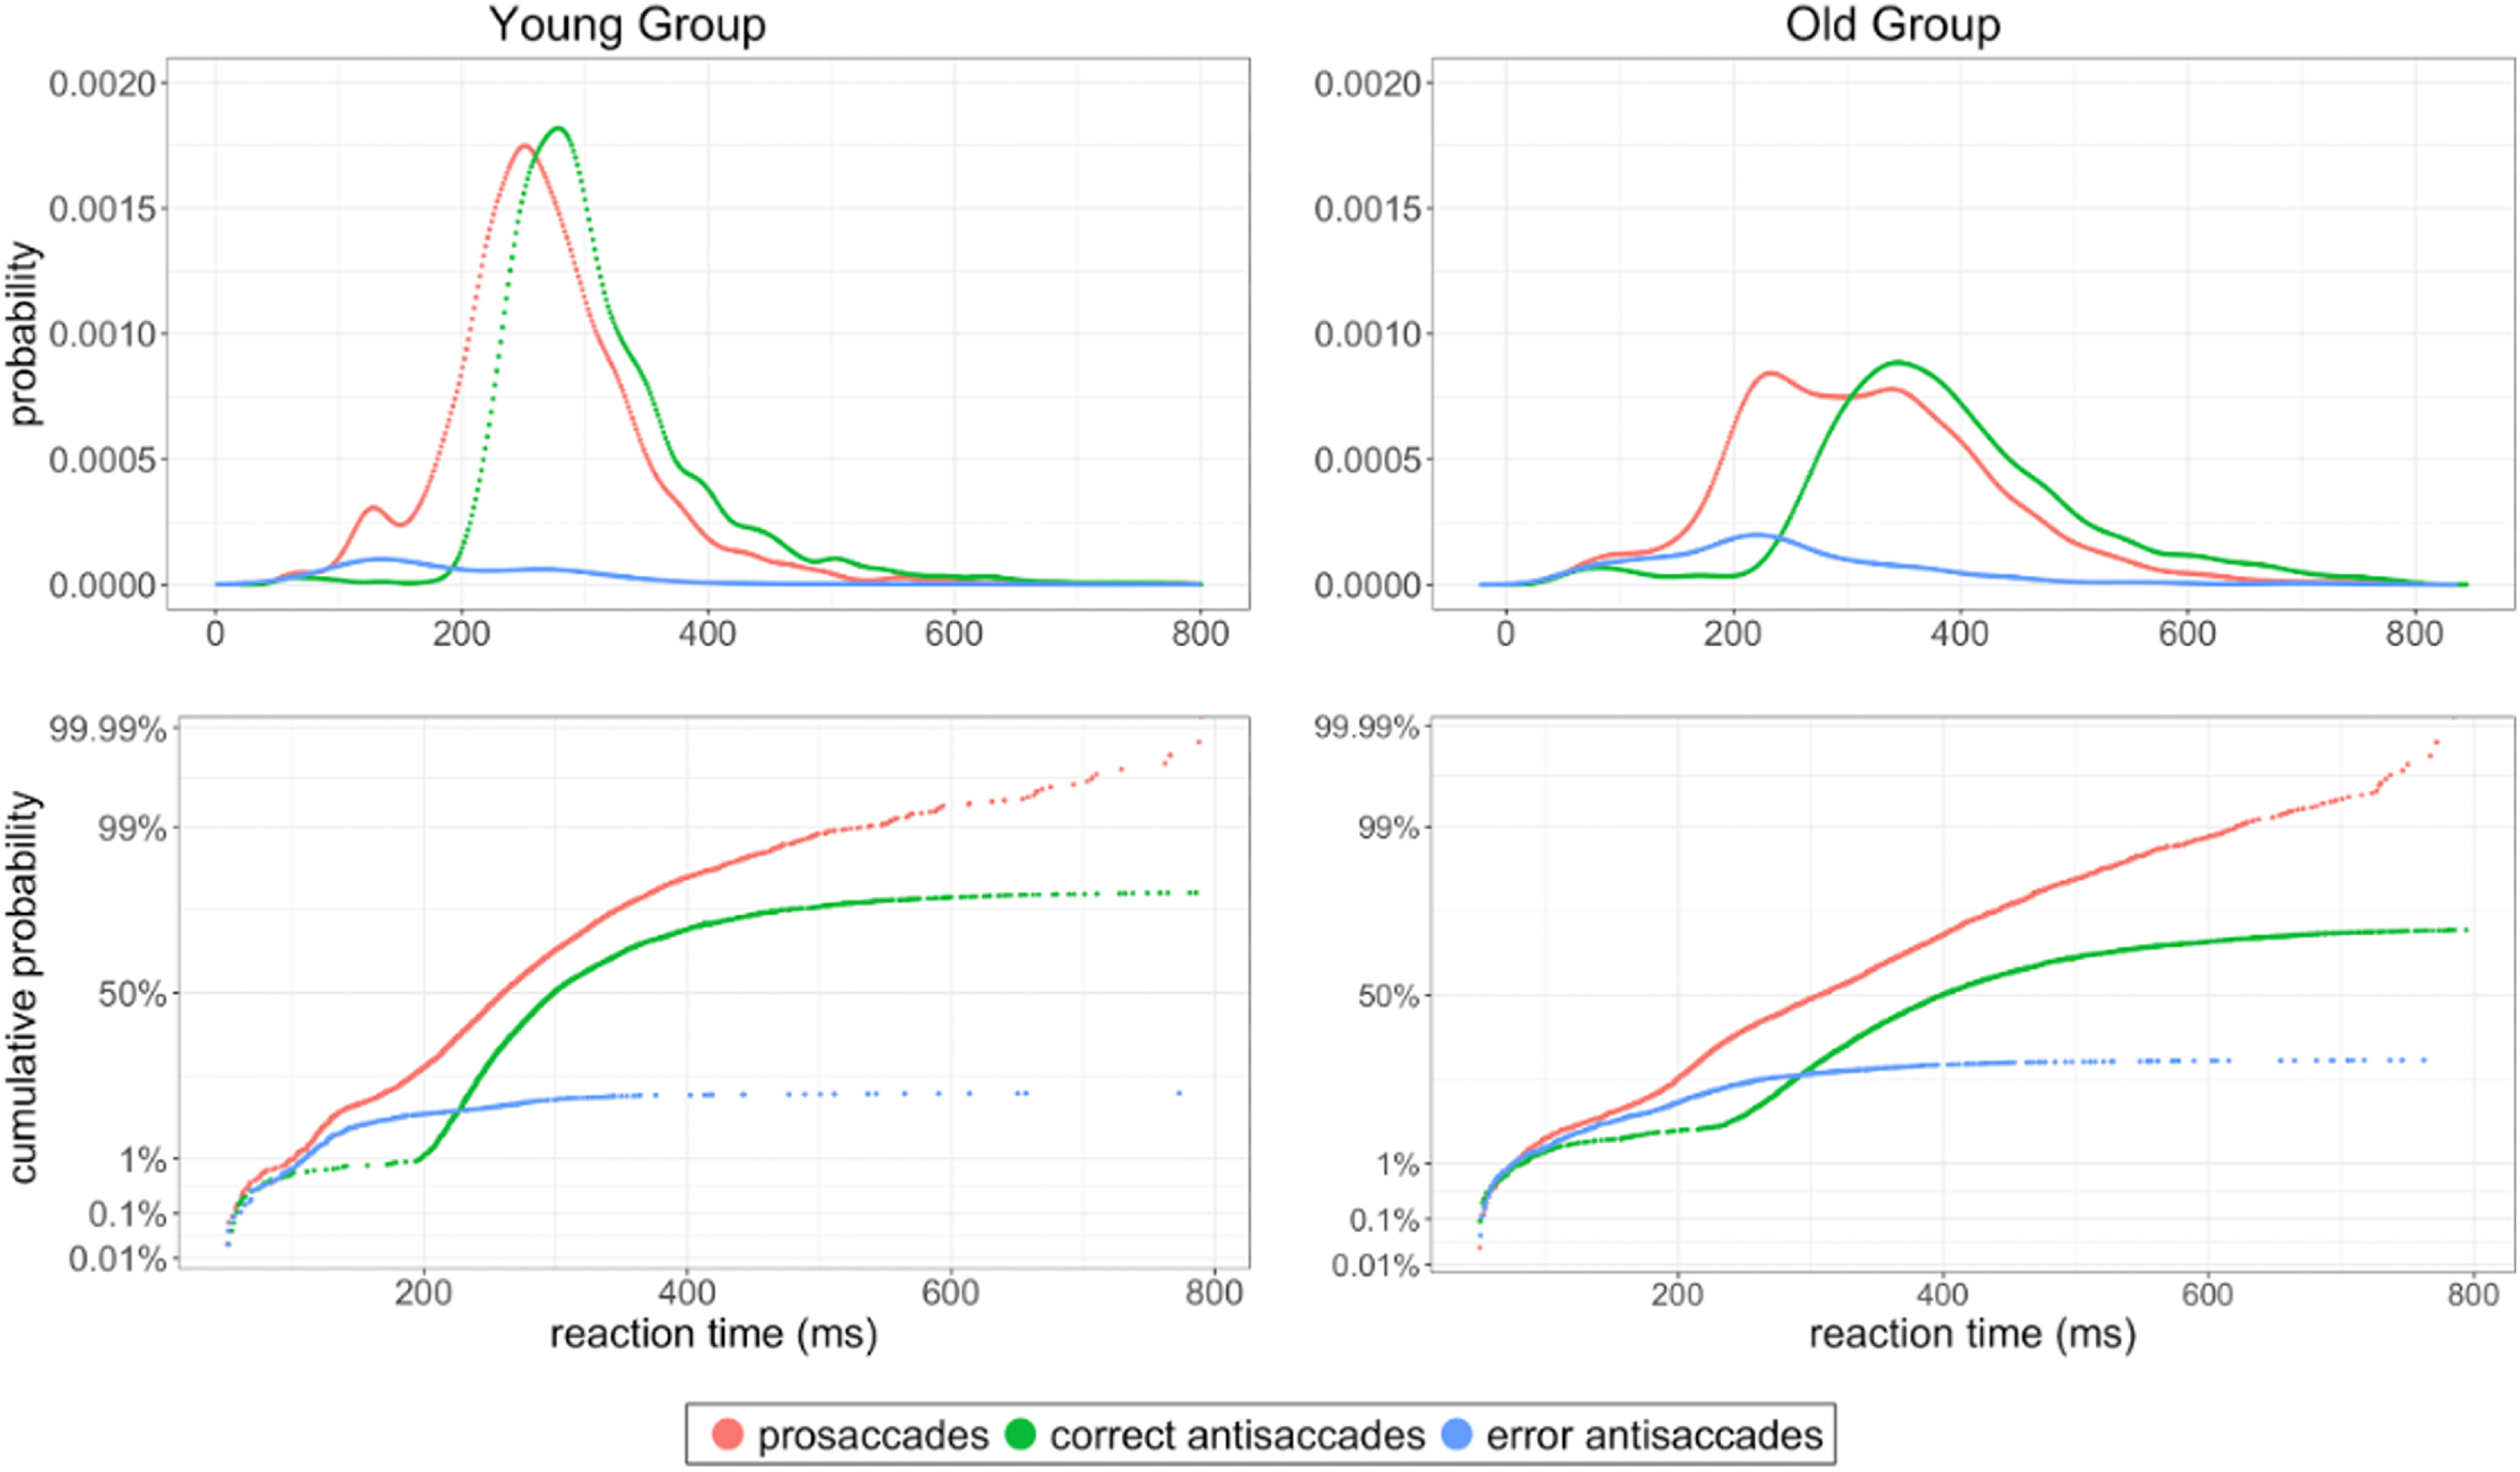
Top panels, Raw distributions with error responses plotted as a cumulative proportion of the total number of trials for young and old group, showing a rightward shift of the correct antisaccade distribution relative to both the prosaccade and error antisaccades distributions. Bottom panels, The same data as shown above as reciprobit plots. Error responses are plotted as a cumulative proportion of the total number of trials.